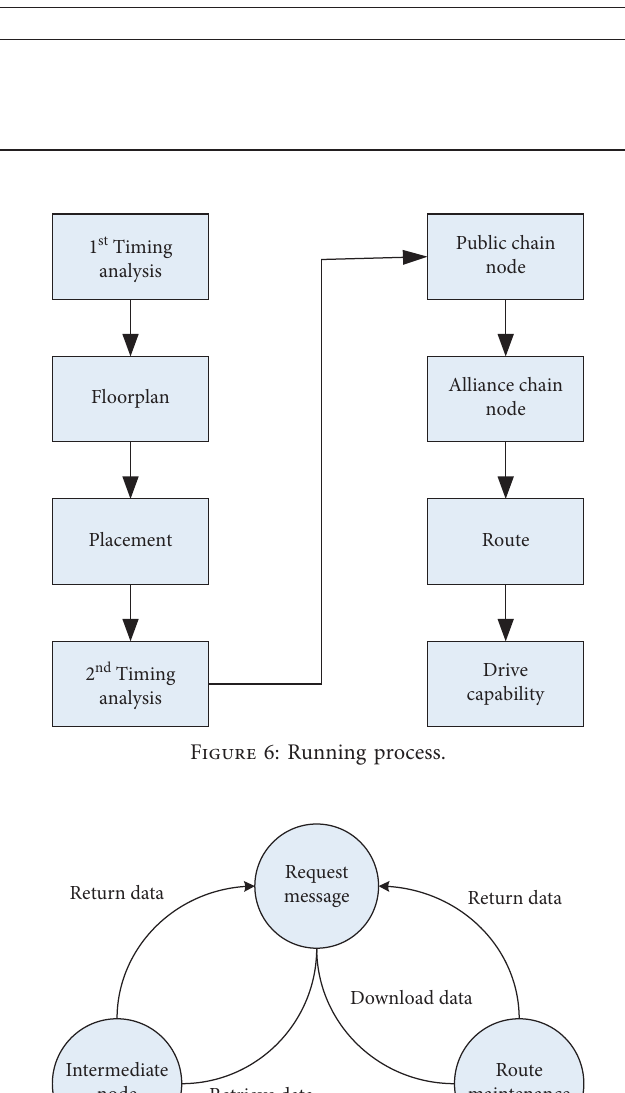
Table 2: Design values of operating nodes.